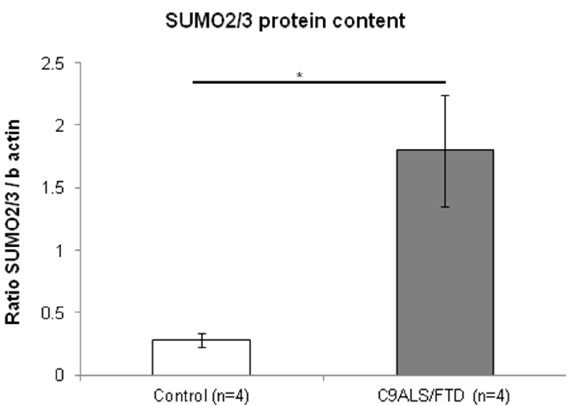
Figure 5. Fibroblasts from C9ALS/FTD patients show increased SUMO2/3 protein content. The results are expressed as means ± standard error of the mean (SEM). Significant p -values were considered for p < 0.05 (*).